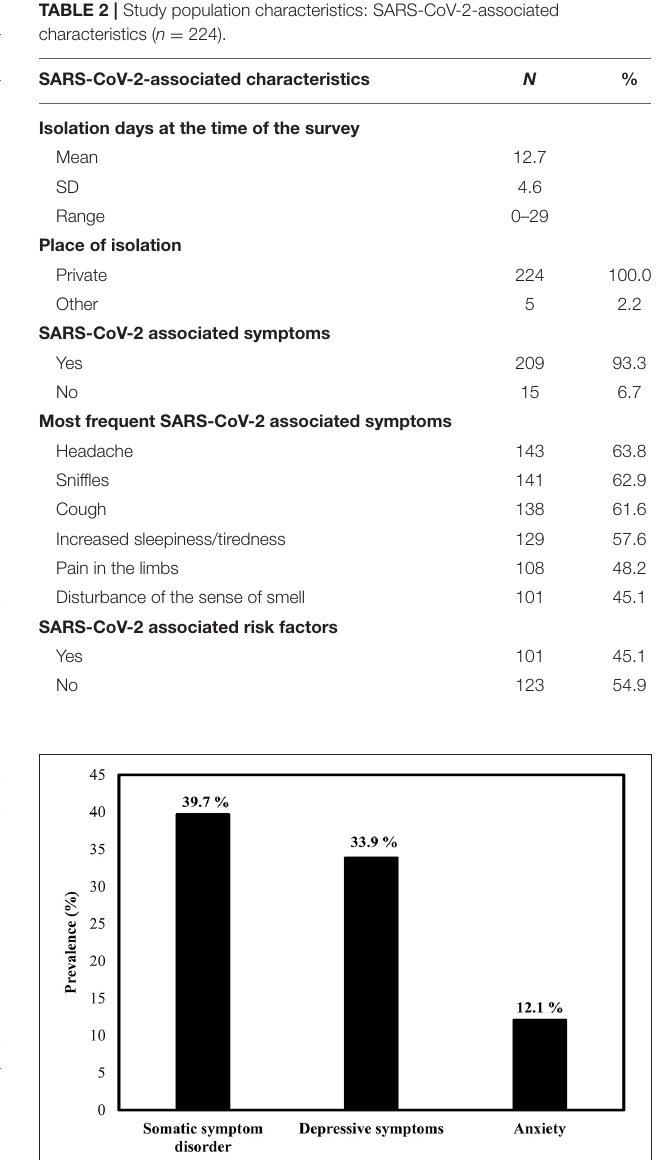
FIGURE 2 | Prevalence of somatic symptom disorder, depressive symptoms, and anxiety.